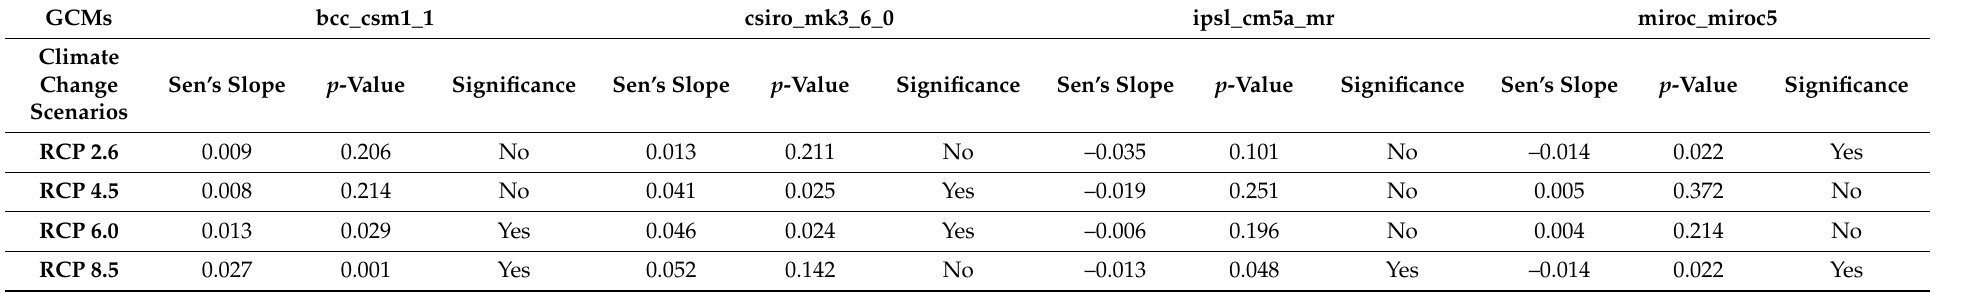
Table 2. Mann–Kendall trend test for maximum annual temperature (2020–2059) with all the four climate change